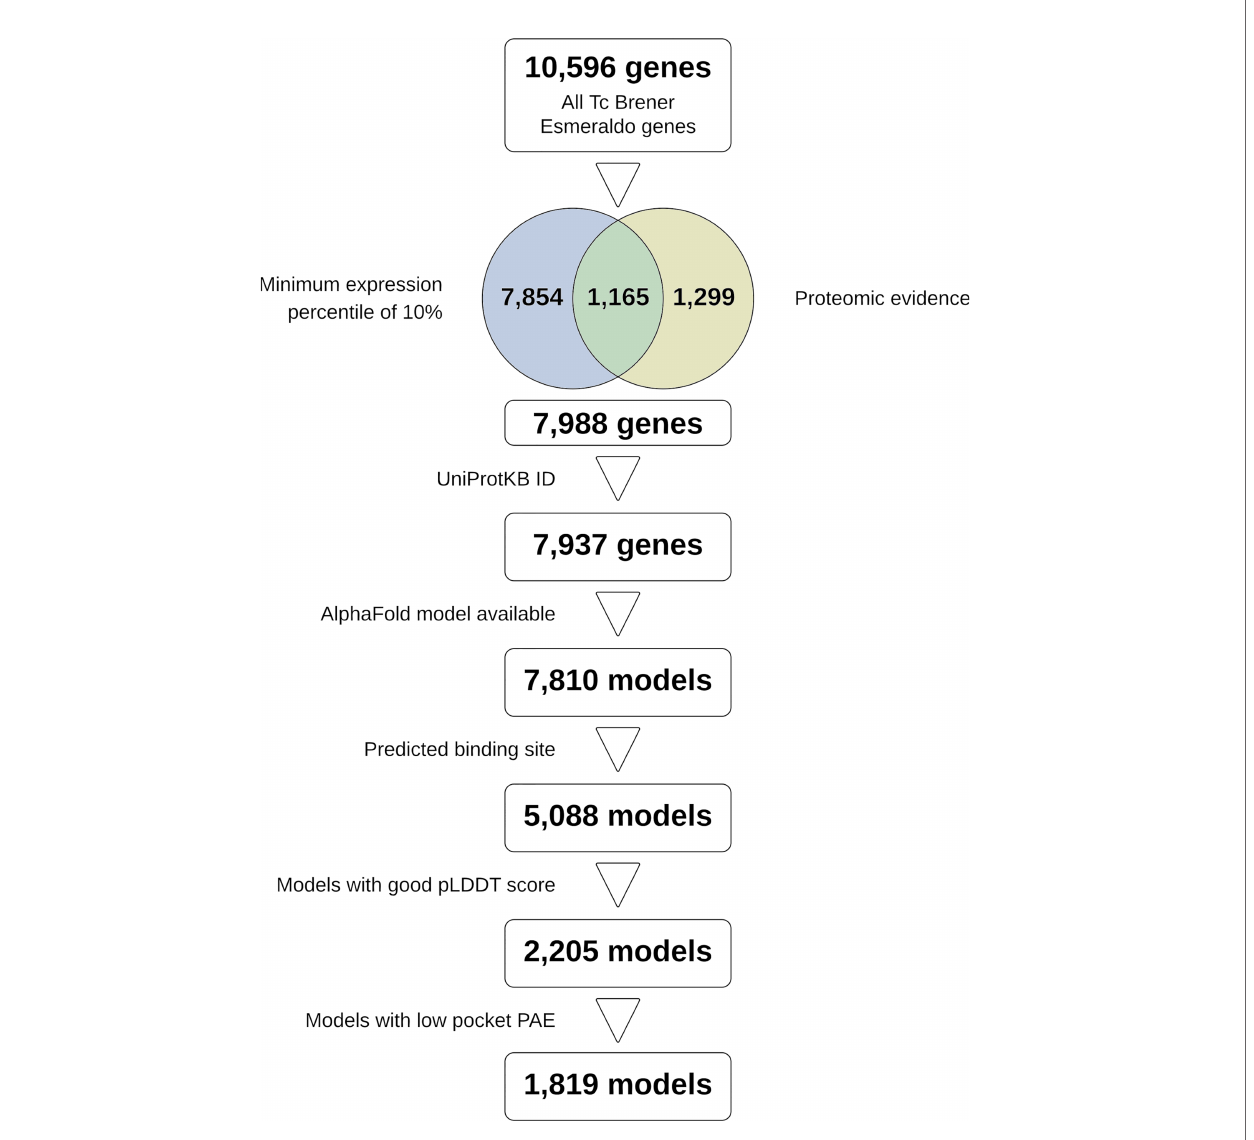
FIGURE 1 | Study fl owchart summarizing the steps followed to reach the models used in docking. Figure made in